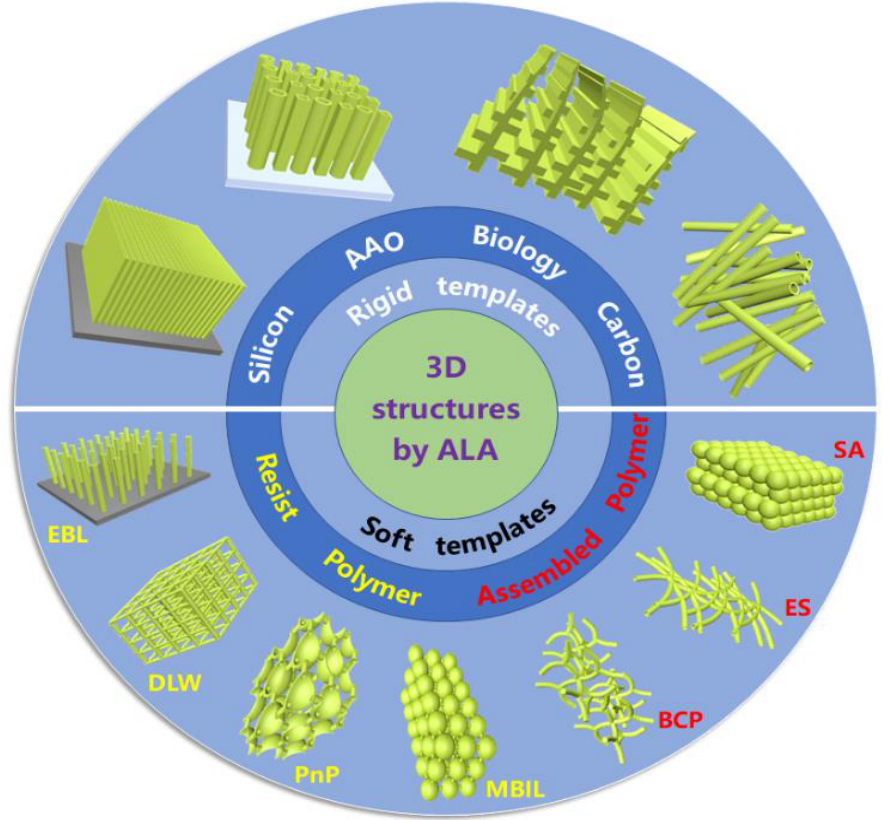
Figure 1. An illustrating summary of the sacrificial templates and obtained typical 3D structures fabricated by atomic layer assembly method. Generally, the sacrificial templates are divided into rigid and soft templates. Typically obtained 3D structures based on ALA method through different sacrificial templates are illustrated in the outer circle of the figure.